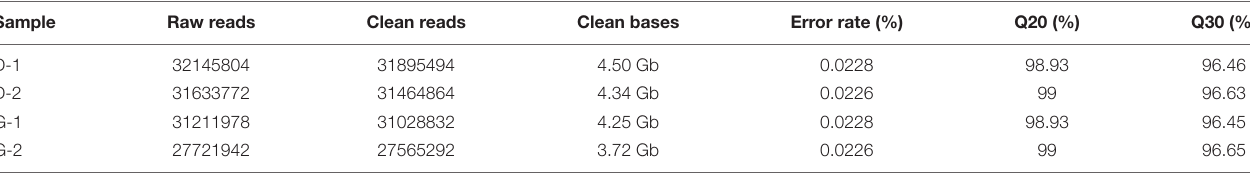
TABLE 1 | Summary of transcriptome sequencing #